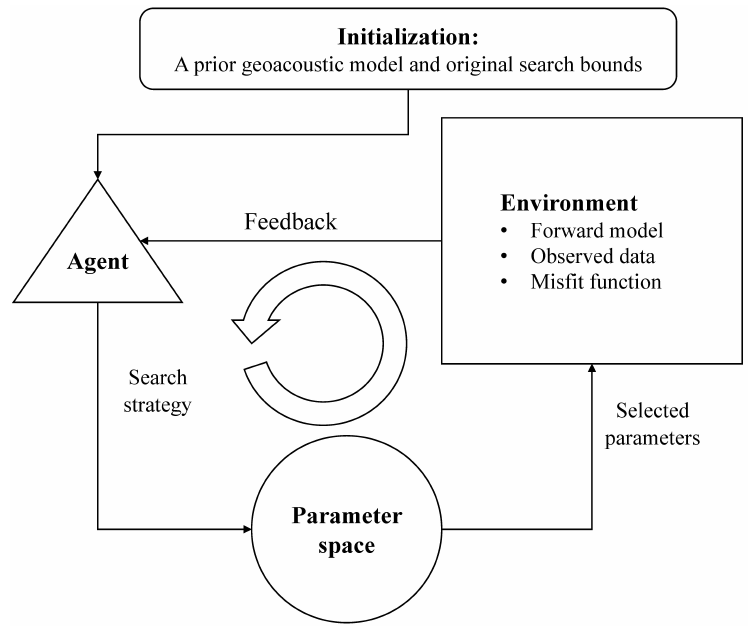
Figure 1. The general workflow of geoacoustic